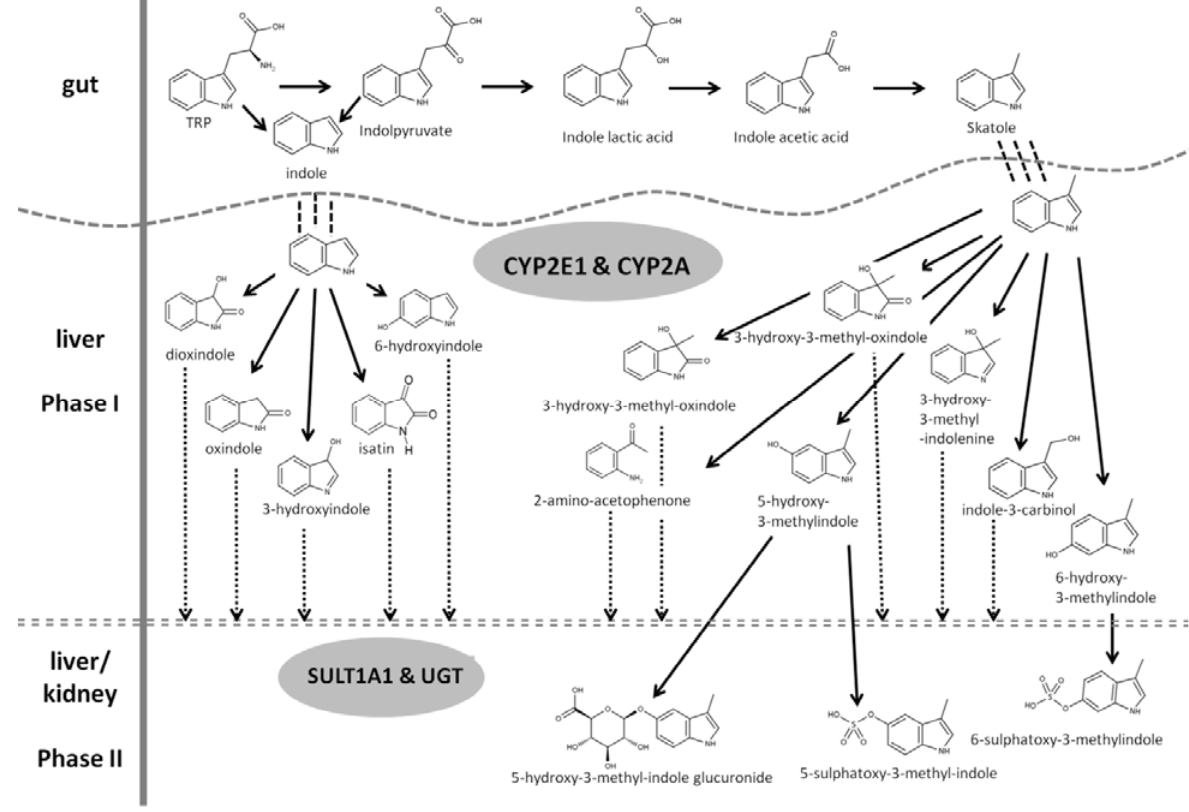
Figure 1. Formation of skatole (3-methyl-indole) and indole from TRP in the gut and further metabolism via phase 1 and phase 2 enzymes, (black arrows: known pathway; broken arrows: assumed pathway)